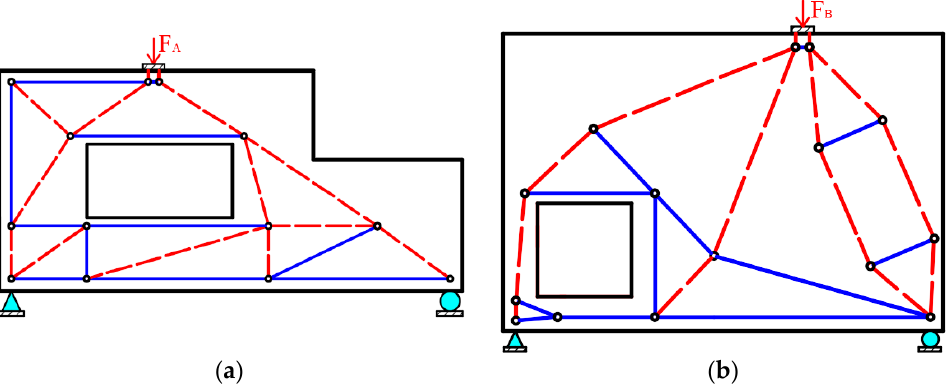
Figure 7. Optimal STMs proposed in this study: ( a ) STM A-04 and ( b ) STM B-04.